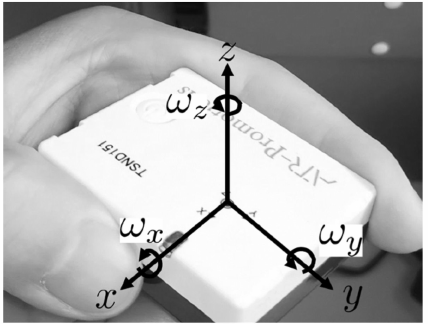
Figure 3. Tilt measurement unit (IMU) coordinate